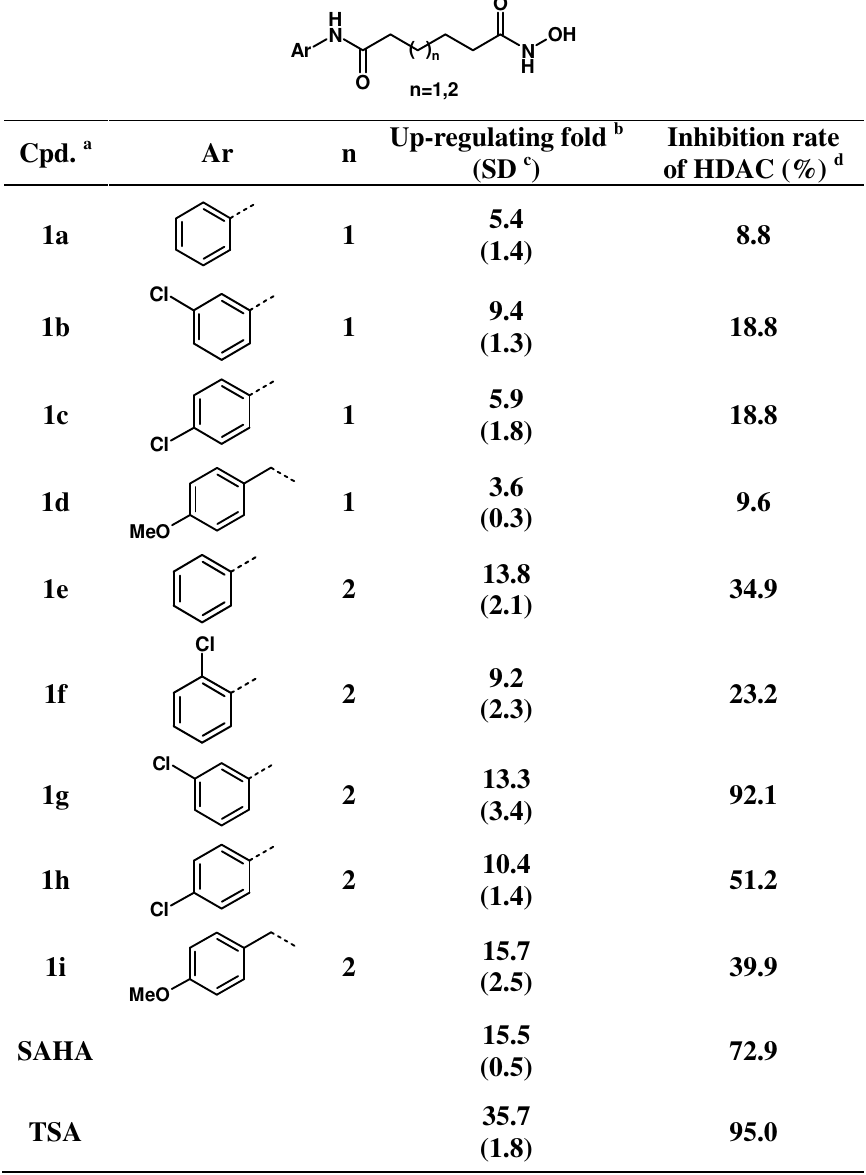
Table 1. Up-regulating activities of CLA-1 expression in HepG2 cells and inhibition rate of HDAC of compounds 1a-i